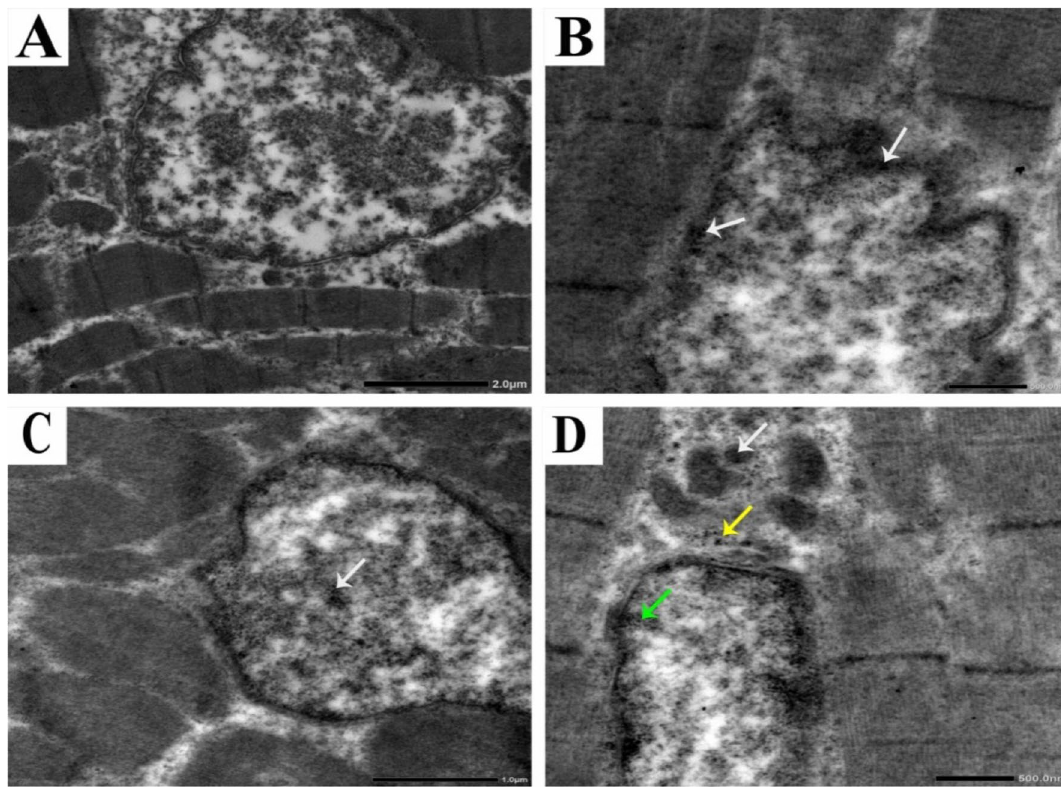
Figure 5. Representative photomicrographs for ultrastructure morphology of muscle tissues from broiler chickens treated with different levels of SiO 2 @AgNPs for 35